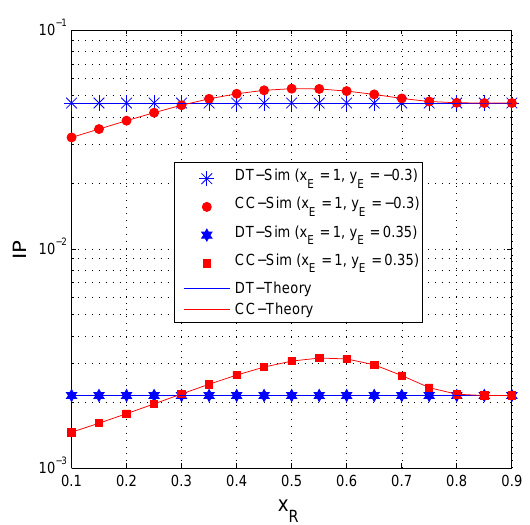
Figure 4. IP as a function of x dB, N max = 6